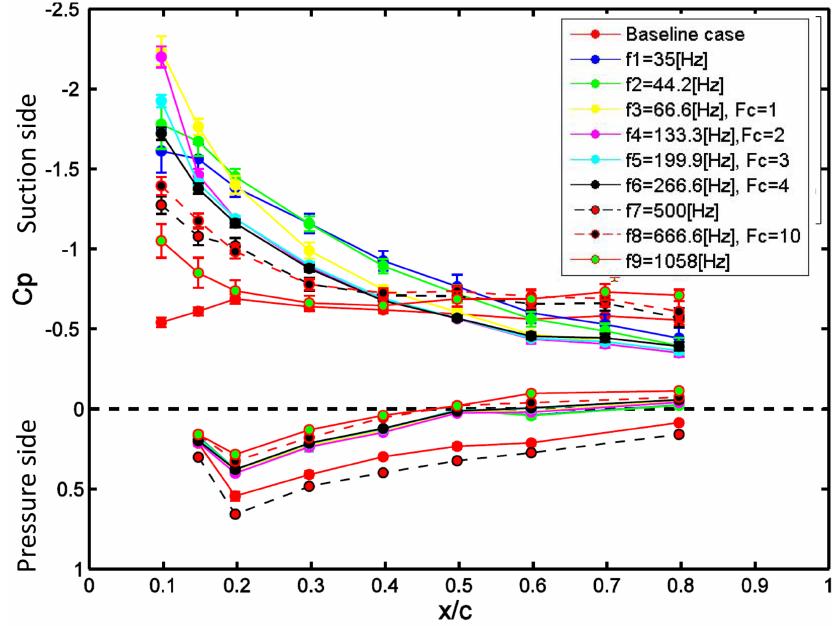
Figure 9. C p distribution at Re = 100,000, U ∞ = 10m/s and α = 16 ◦ .